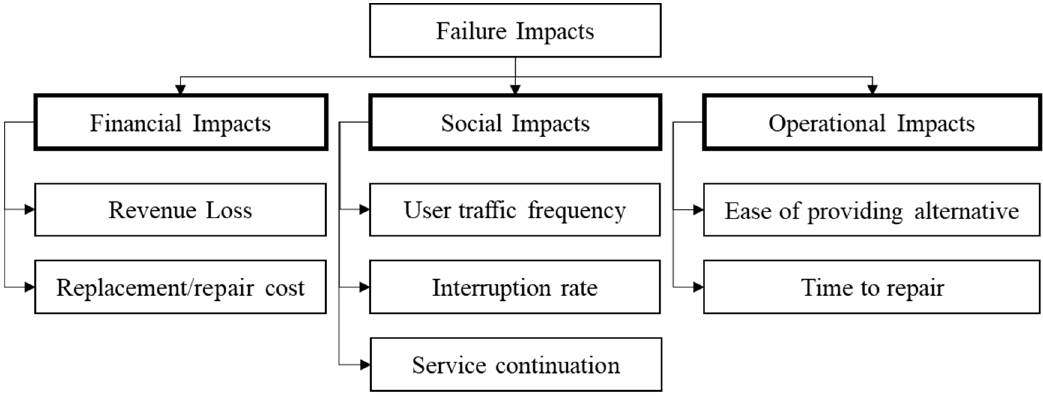
Figure 1. Failure impacts Attributes [6].